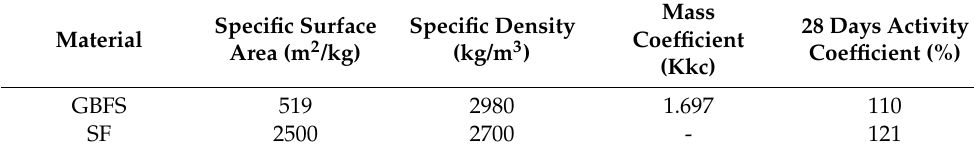
Table 3. Physical properties of GBFS and SF.